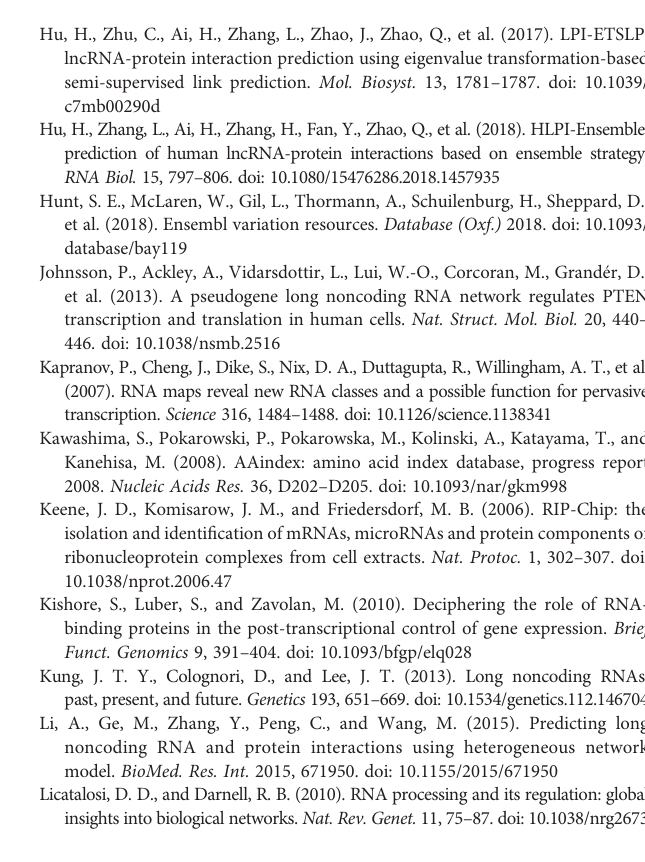
TABLE S1 | 2862 experimentally veri fi ed lncRNA-miRNA interactions. TABLE S2 | 2521 experimentally veri fi ed protein-miRNA interactions. TABLE S3 | 40668 experimentally veri fi ed lncRNA-protein